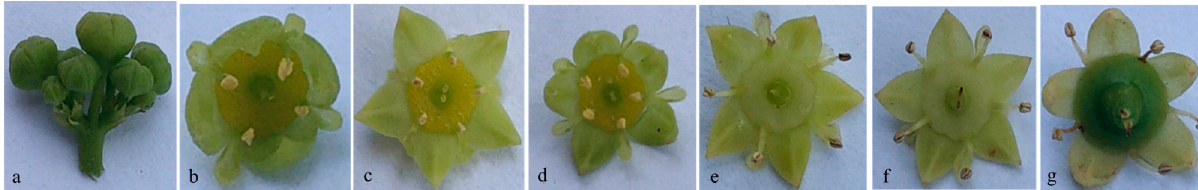
Figure 1. Flower development stages of ‘Maya’ jujube. ( a ): bud split; ( b ): initial opening; ( c ): sepal flattening; ( d ): petal flattening; ( e ): stamen flattening; ( f ): stamen withering, ( g ): ovary swelling.